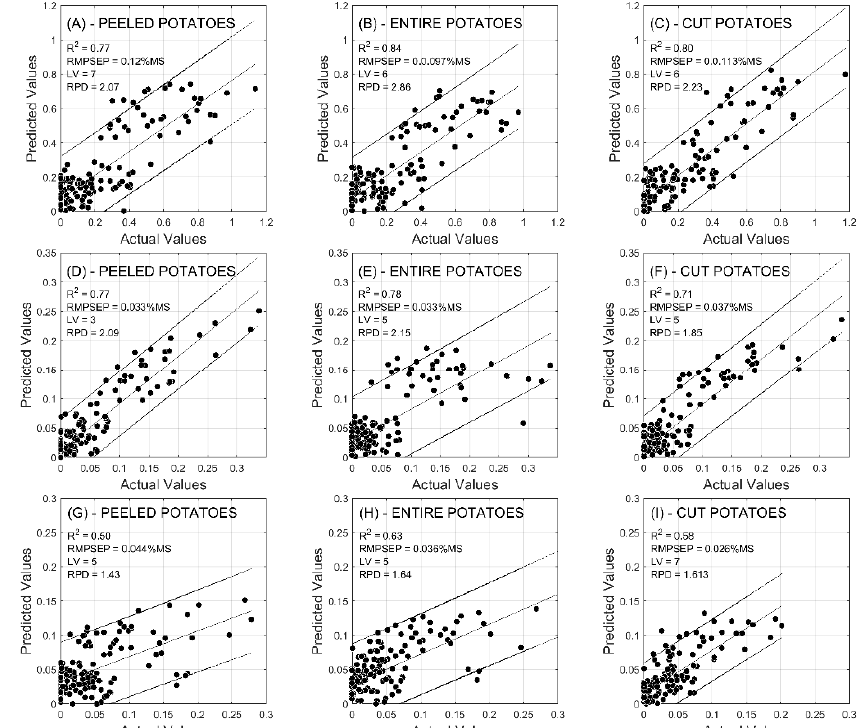
Figure 3. Actual vs. predicted values of Innovator’s ( A – C ), Markies’ ( D – F ) and Lady Claire’s ( G – I ) reducing sugars contents. Predictions were performed based on “Entire and peeled” ( A , D , G ) tubers, “Entire and unpeeled” tubers ( B , E , H ), and tubers “cut transversally” ( C , F , I ). PDTP (peeled potatoes) configuration allowed us to reach the most accurate models. Reducing sugar (fructose + glucose) were predicted with RPD values of 2.07 (PDTE), 2.86 (PDTP), and 2.23 (PDTC) for Innovator, 2.09 (PDTE), 2.15 (PDTP), and 2.1.85 (PDTC) for Markies, and 1.43 (PDTE), 1.64 (PDTP), and 1.61 (PDTC) for Lady Claire. In the same way, R 2 and RMSE values were generally favored by the PDTP configuration (Tables